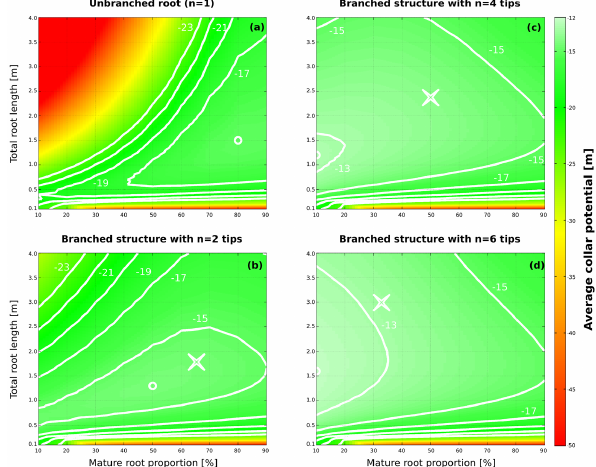
Figure 4. Effort ˜ w depending on topology and composition of sin- gle roots, obtained with the simple model. Results are shown for (a) unbranched roots and branched roots (fishbone structures) with (b) two, (c) four and (d) six tips. Root composition is given by to- tal root length ( y axis) and the proportion of mature roots ( x axis). Colours are the same as in Fig. 3 (bottom left). Optimal values of effort are denoted by white circles. The crosses in (b–d) indicate effort for a root that is the same as the optimal unbranched hetero- geneous root from (a) except for containing one, three and five more equal young root tips,